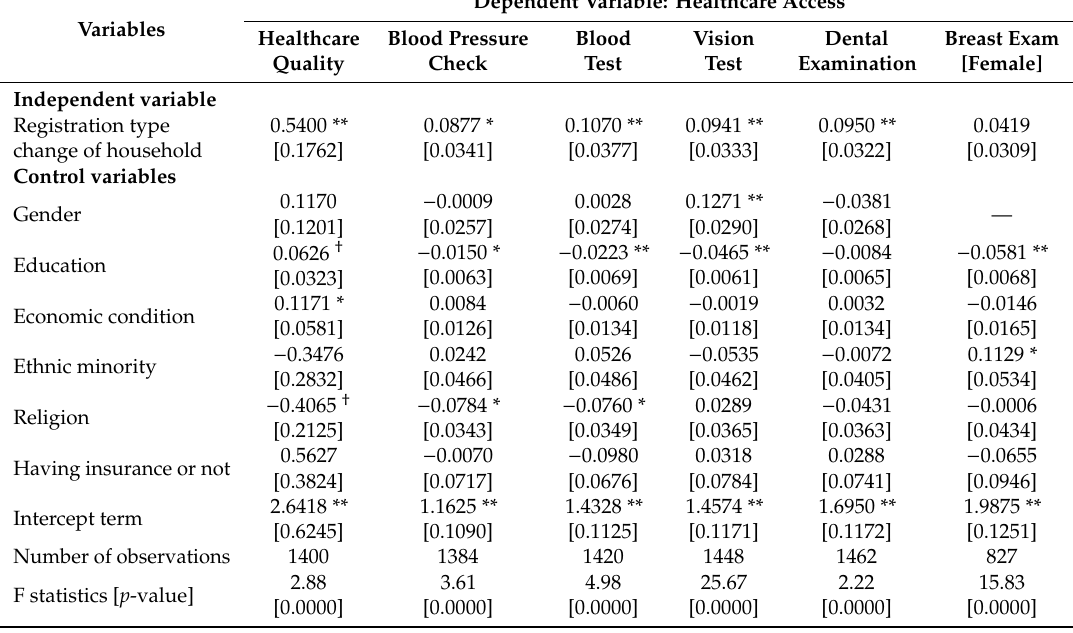
Table 5. E ff ect of household registration (hukou) type change on healthcare access for rural residents that have never migrated to other areas.